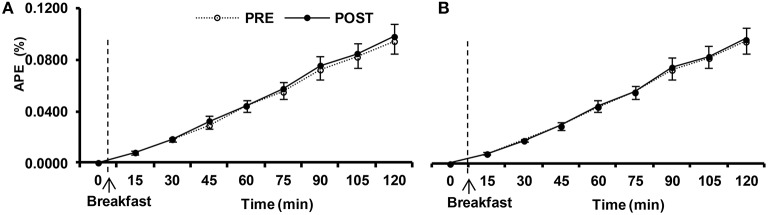
Isotopic enrichement of expired CO2 expressed in atom percent excess (APE) in postprandial response before (PRE) and after (POST) the 10-day normoxic (NORMOXIC; A) and hypoxic (HYPOXIC; B) confinements. Values are mean ± SEM. *Indicates significant (p < 0.05) difference between PRE and POST confinement.